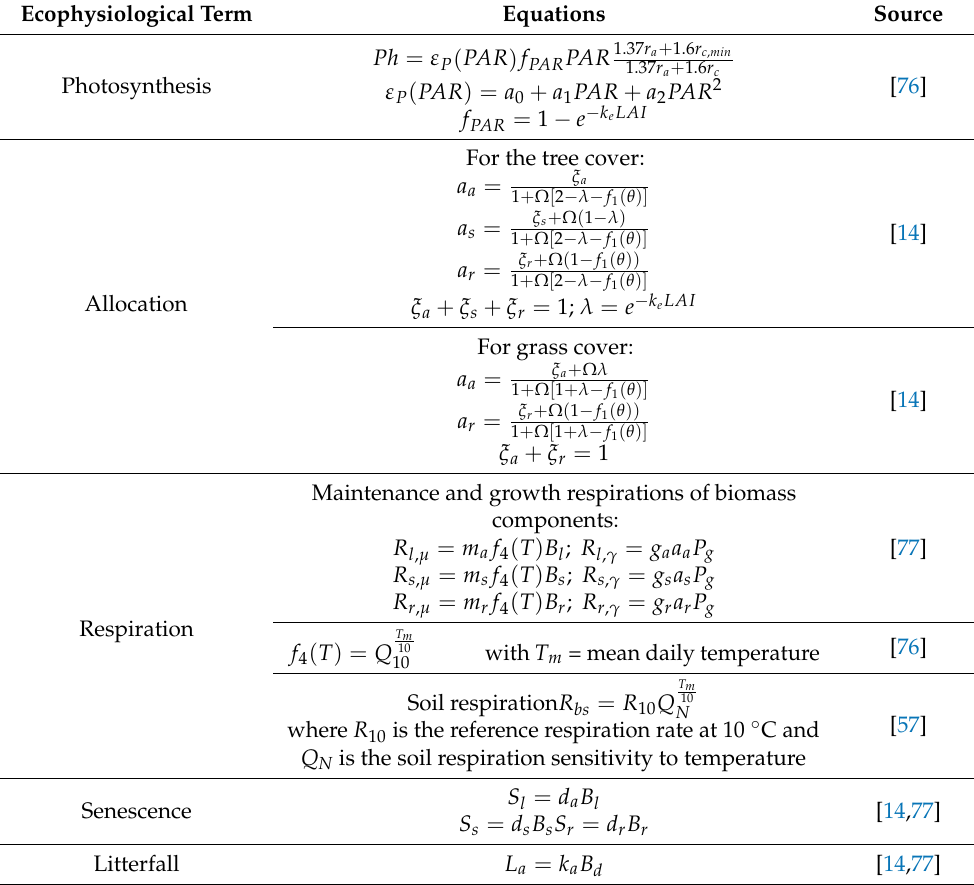
Table 2. Equations of the vegetation dynamic model components. Parameters are defined in Table